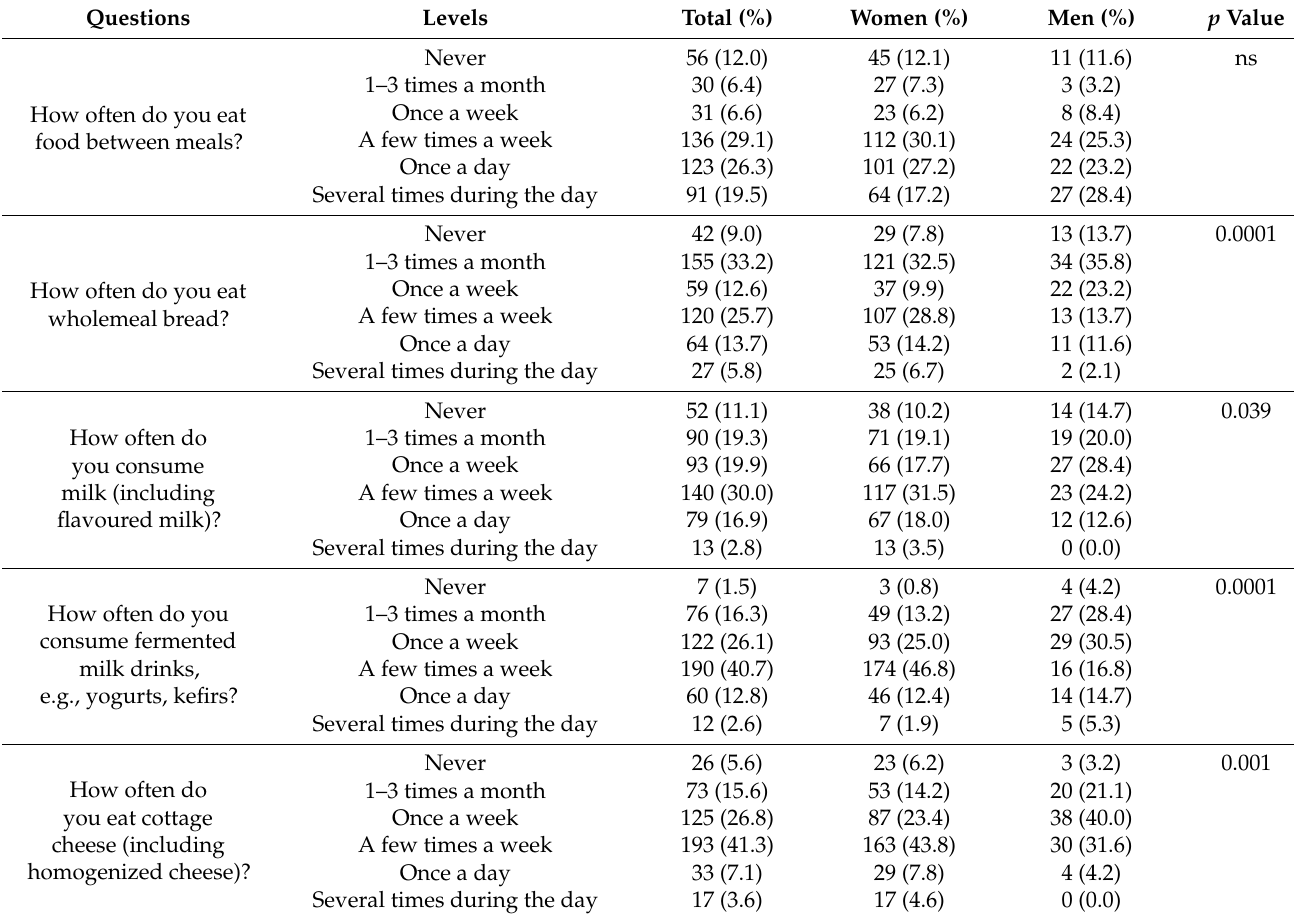
Table 4. Frequency of consumption of selected groups of food products.